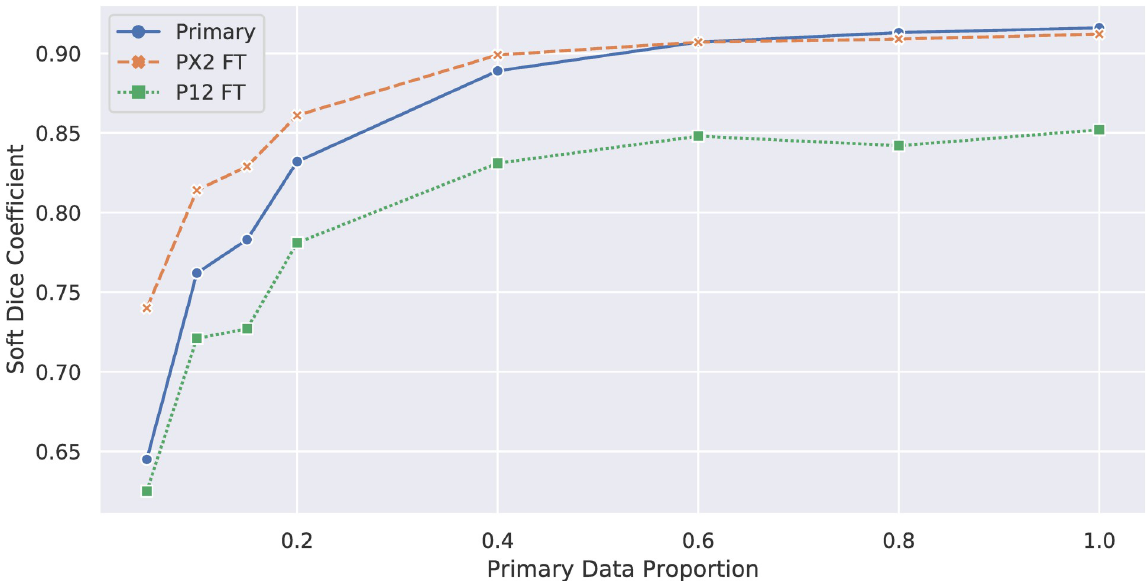
Fig 4. Soft Dice coefficients for models trained with ablated dataset. Soft Dice Coefficients for models trained using the ablated primary dataset (“Primary”) or trained using an ablated primary model as weight initializer (“FT”). PX2 = ProstateX-2, P12 = PROMISE12, FT = fine- tuned. Significant improvements can be seen in the performance of the fine-tuned models at 5% of the primary dataset used for training the ablated primary baseline model, with the performance benefits leveling out at 60% of the dataset.